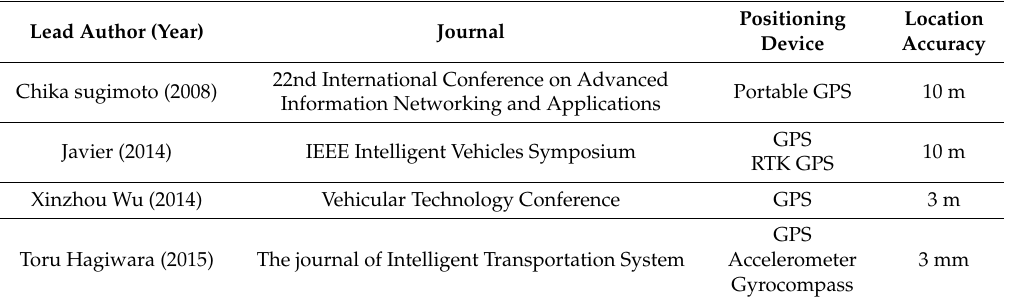
Table 4. Analyzing the accuracy of